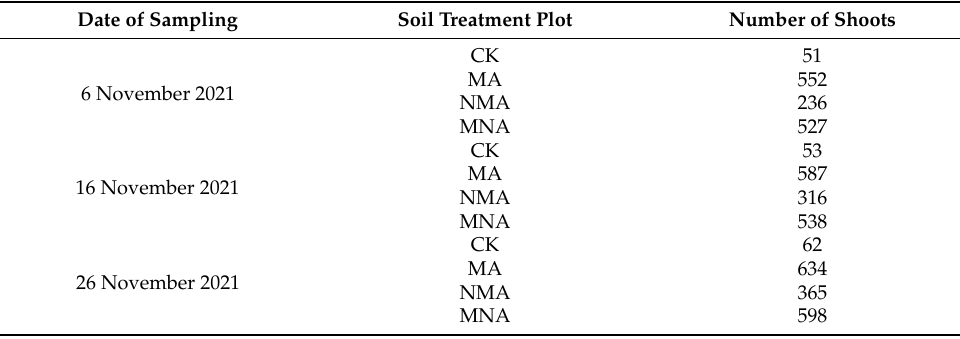
Figure 1. Experimental plot layout and soil sampling overview. Table 1. The number of bamboo shoots per plot on different sampling